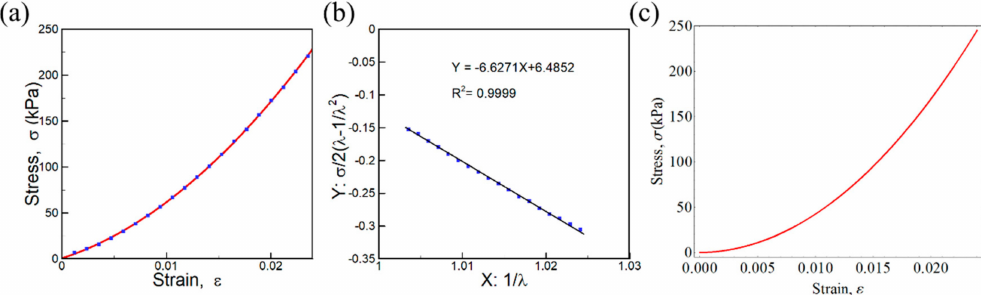
Figure 6. ( a ) The measured stress-strain diagram of polydimethylsiloxane (PDMS) sensing layer; ( b ) calculated Mooney–Rivlin plot ( σ / λ − 1 / λ 2 verses 1 / λ ); ( c ) the calculated stress-strain diagram of PDMS using the third-order Mooney model from Equation (10).